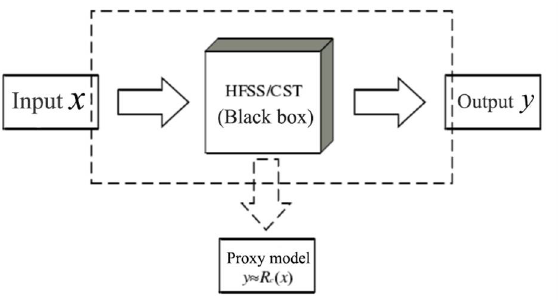
Figure 4. The illustration of surrogate model design. The output value can be calculated by commer- cial software automatically.